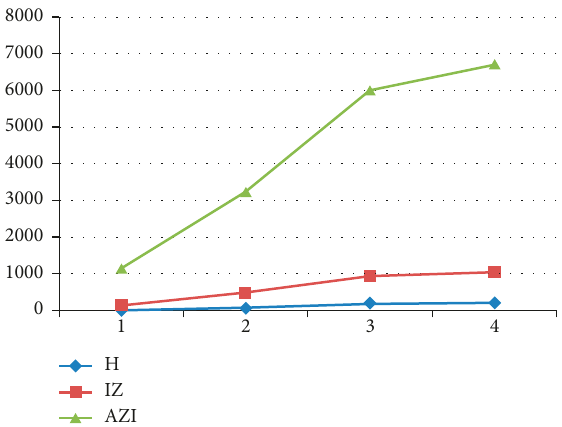
Figure 7: Comparison among different indices of (TM-TCNB) 2